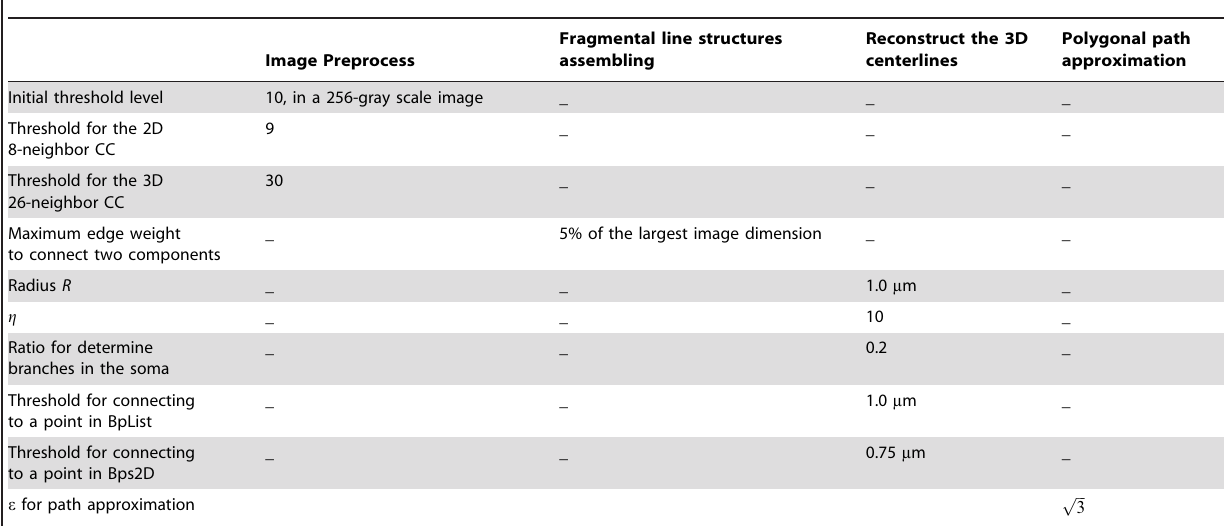
Table 2. Parameters for